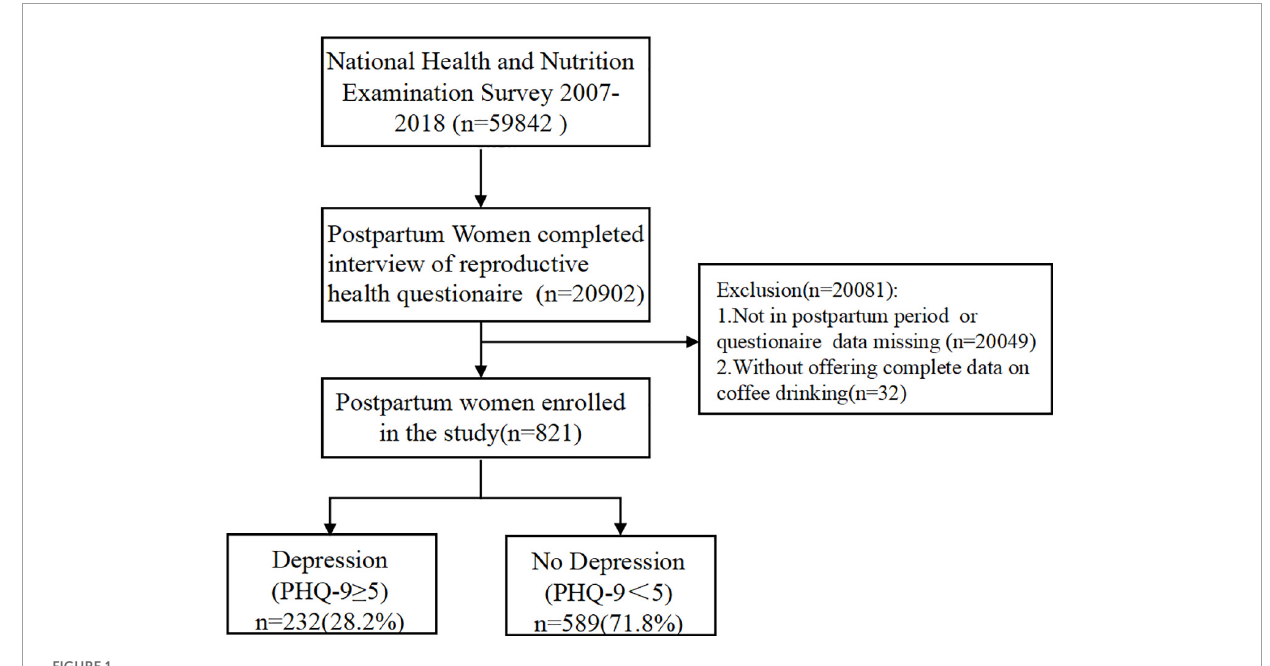
FIGURE1 Flowchart illustrating the selection of participants.